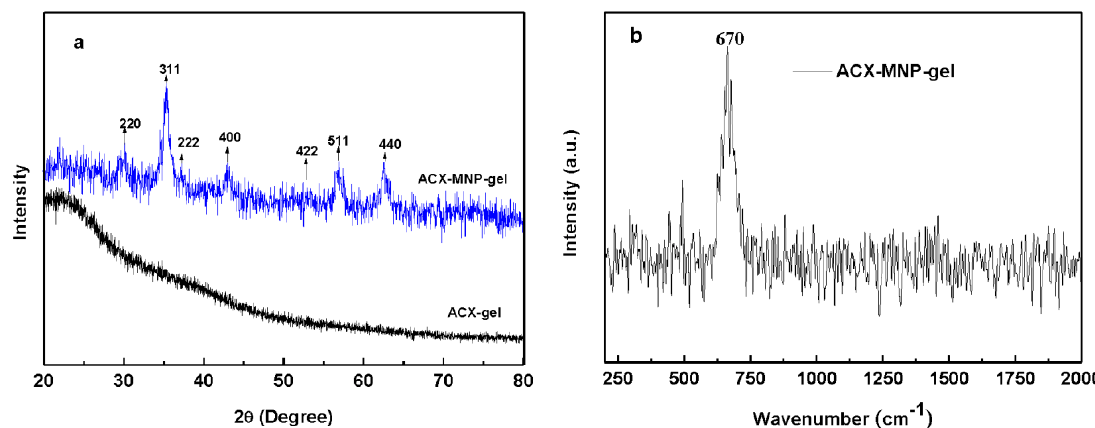
Figure 2. The crystal structure of Fe 3 O 4 nanoparticles in situ fabricated within the ACX-MNP-gel matrix (C = 5.0 wt %). ( a ) XRD spectra; ( b ) Raman spectra.